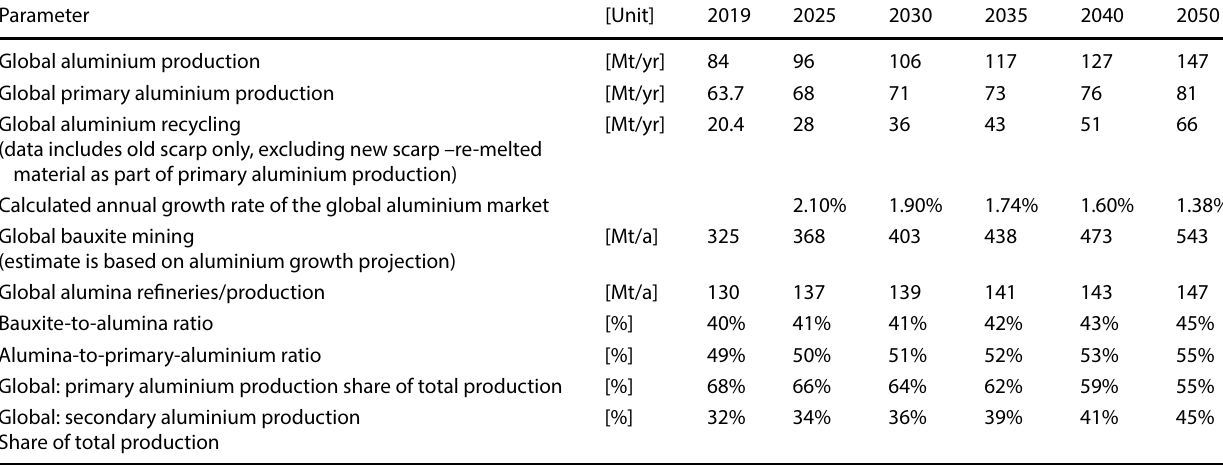
Table 6 Assumed global aluminium market development Parameter